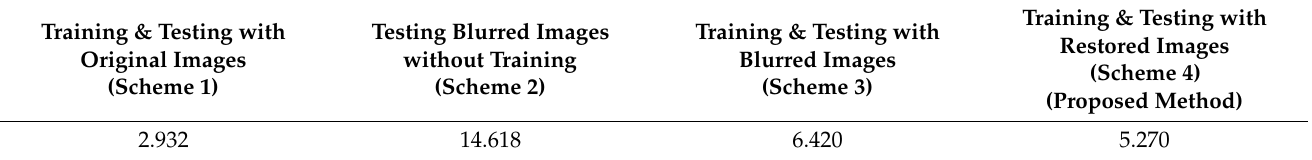
Table 5. Comparison of finger-vein recognition error (EER) with respect to the applicable of a motion blur with SDU-DB (unit: %).